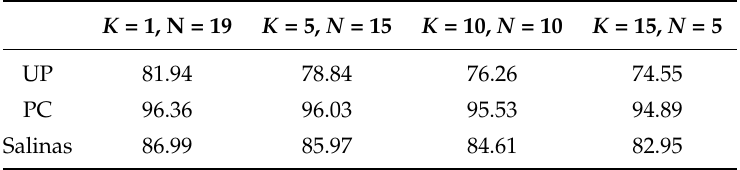
Table 5. Overall accuracy (%) with different combinations of K and N